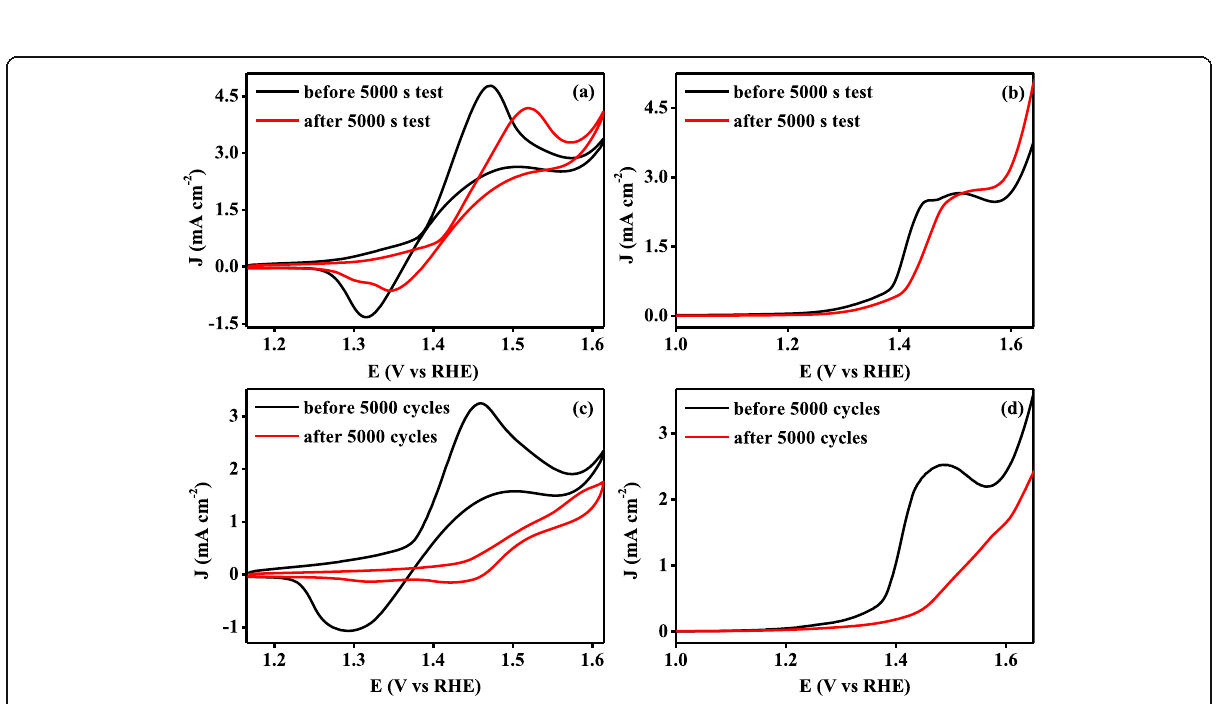
Fig. 4 a Cyclic voltammetric curves and b linear sweep voltammetric curves of Ni 6 /AB composites before and after 5000 s i - t tests. c Cyclic voltammetric curves and d linear sweep voltammetric curves of Ni 6 /AB composites before and after 5000 cycles. The scan rate for CVs and LSVs is 50 mV/s and 10 mV/s,